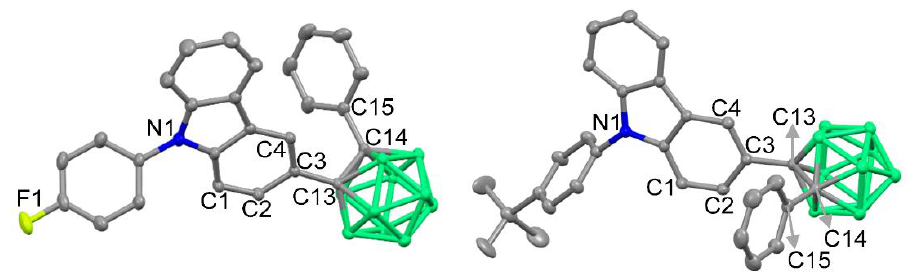
Figure 1. Synthetic routes for 9-phenyl-9 H -carbazole-based o -carboranyl compounds ( 1F , 2P , 3M , and 4T ). Reaction conditions: (i) phenylacetylene, CuI, Pd(PPh 3 ) 2 Cl 2 , toluene/NEt 3 (2/1, v / v ), 120 °C, 24 h; (ii) CuI, K 3 PO 4 , trans -1,2-diaminocyclohexane, 1-fluoro-4-iodobenzene (for 1FA ) or 1- bromo-4- tert -butylbenzene (for 4TA ), 120 °C, 24 h; (iii) B 10 H 14 , Et 2 S, toluene, 120 °C, 72 h.